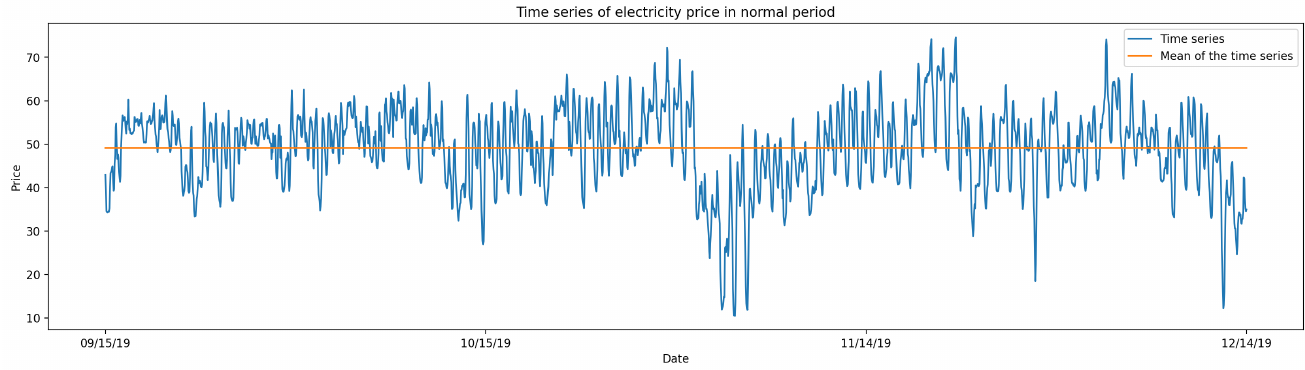
Figure 4. Time series of normal period. On the x-axis we can see that this period covers electricity prices from September to December 2019. The horizontal line which can be seen indicates the average for that period with a value of